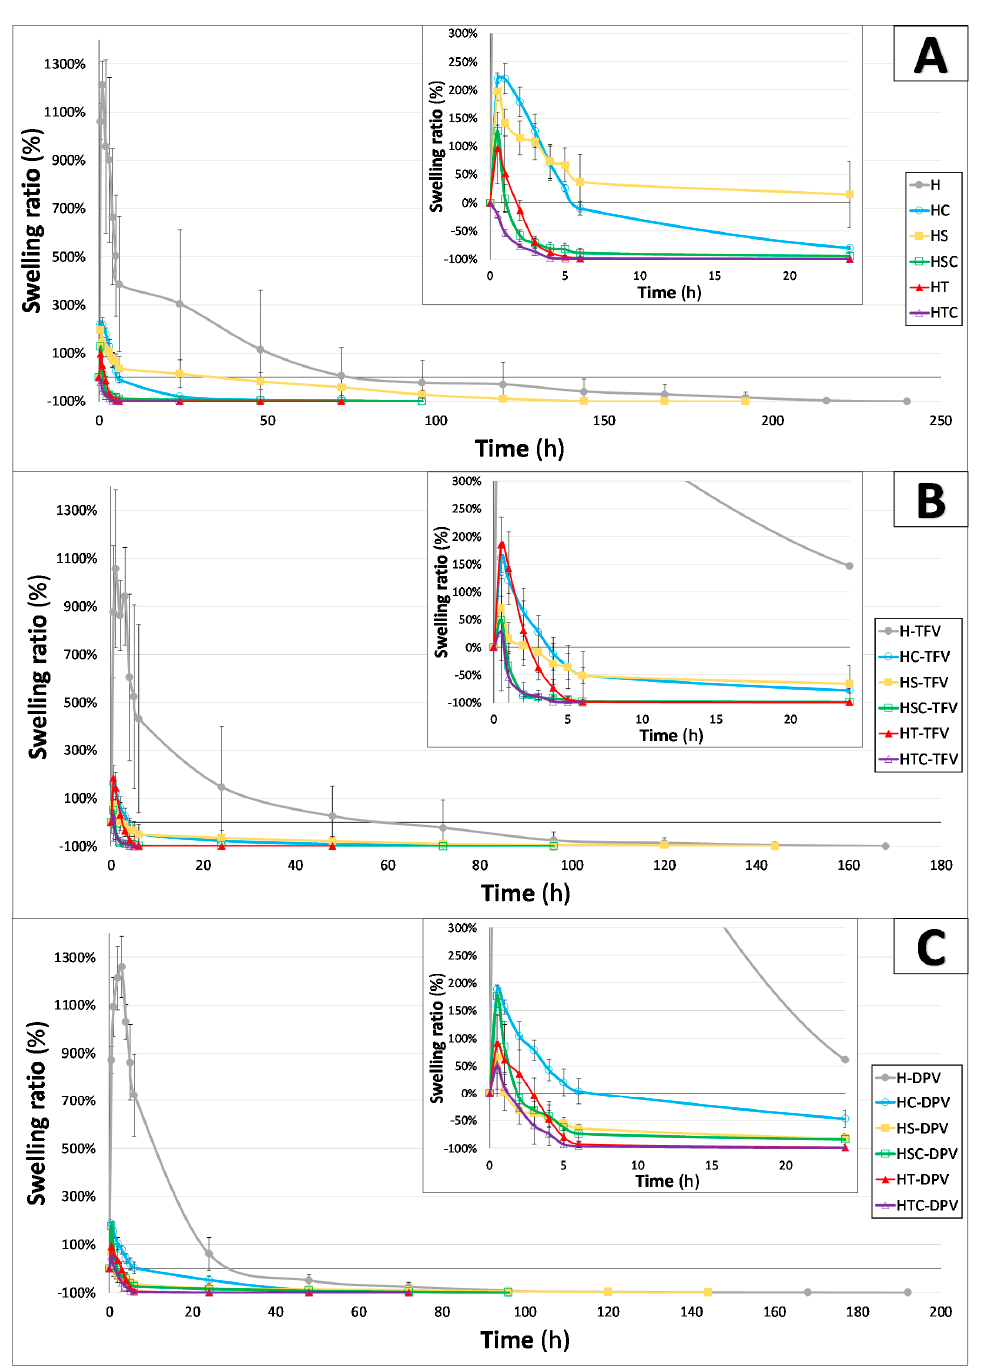
Figure 9. Swelling ratio profile of unloaded ( A ), TFV-loaded ( B ), and DPV-loaded ( C ) vaginal discs immersed in simulated vaginal fluid. The values obtained up to 24 h of trial are expanded inside each picture. Mean ± SD are presented ( n = 3).